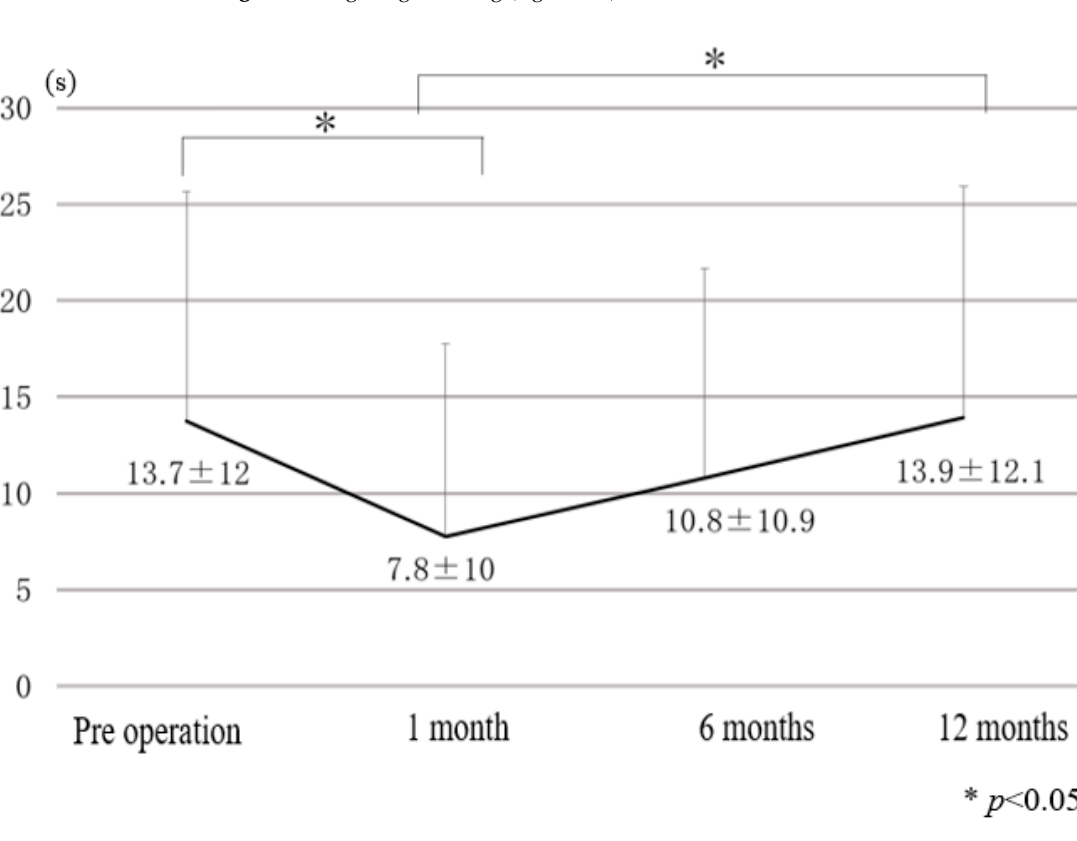
Figure 7. Single leg standing (left side).